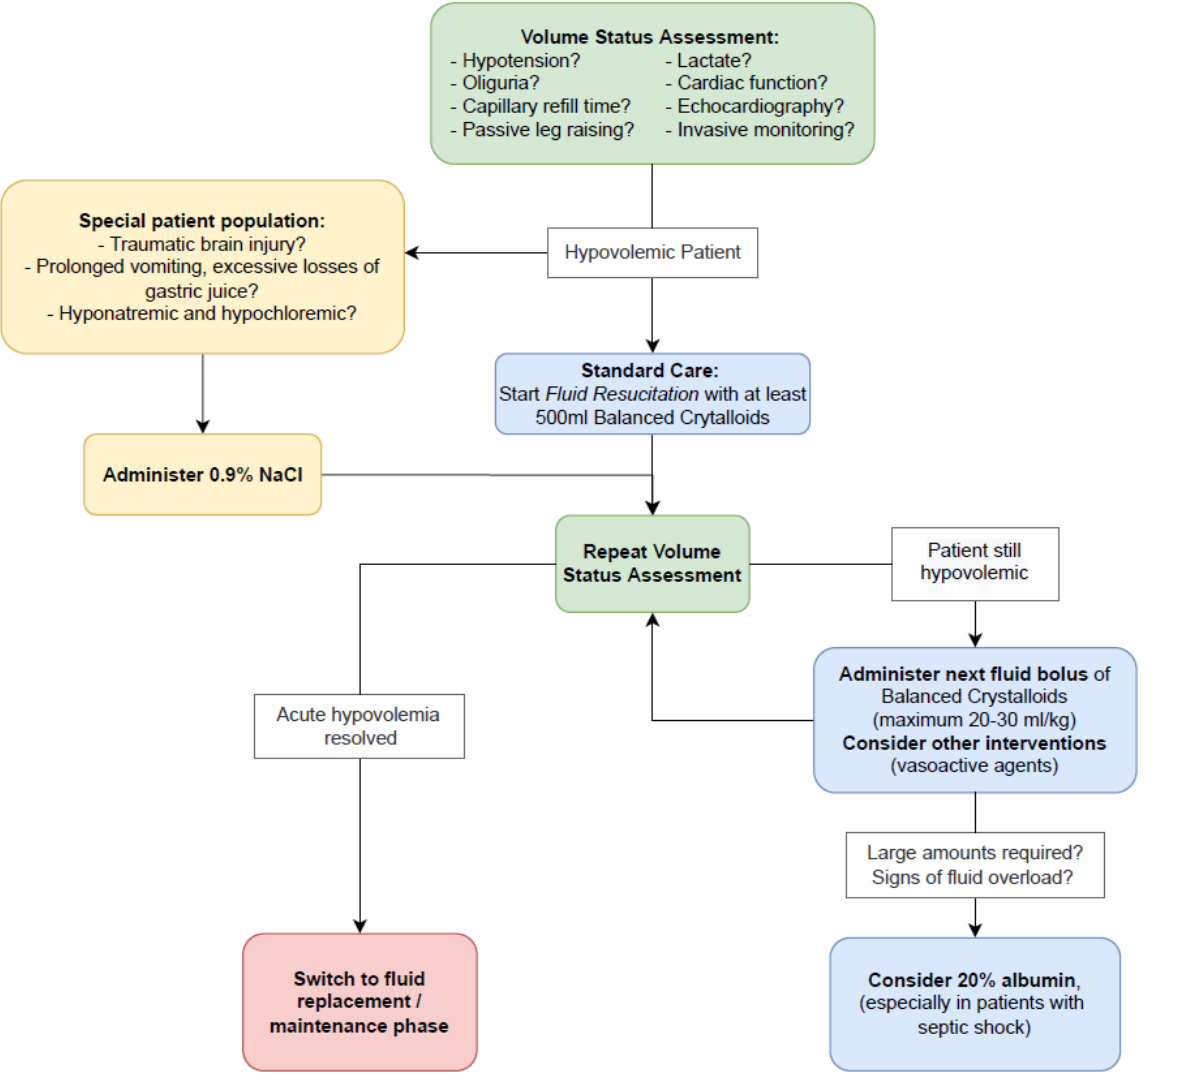
Figure 2. Main considerations for fluid resuscitation in hypovolemic critically ill patients. Reprinted with permission from Ref. [2]. Copyright © 2022, Oxford University Press.